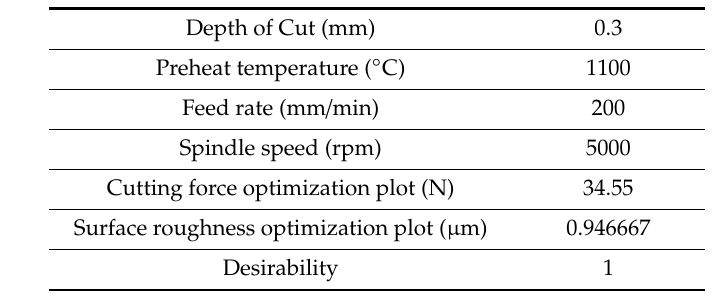
Table 12. Response optimization